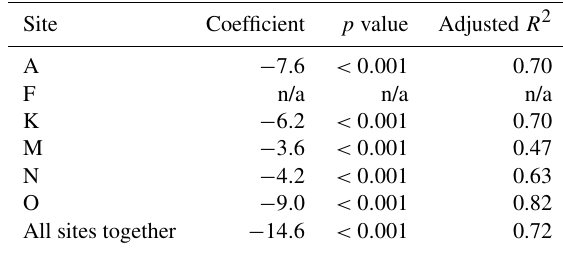
Table 5. Linear regression between distance from the tree edge and decreasing snow depth within a 10m buffer toward the open. Site F had no trees with a decreasing trend (n/a). The p values > 0 . 001 are described as not